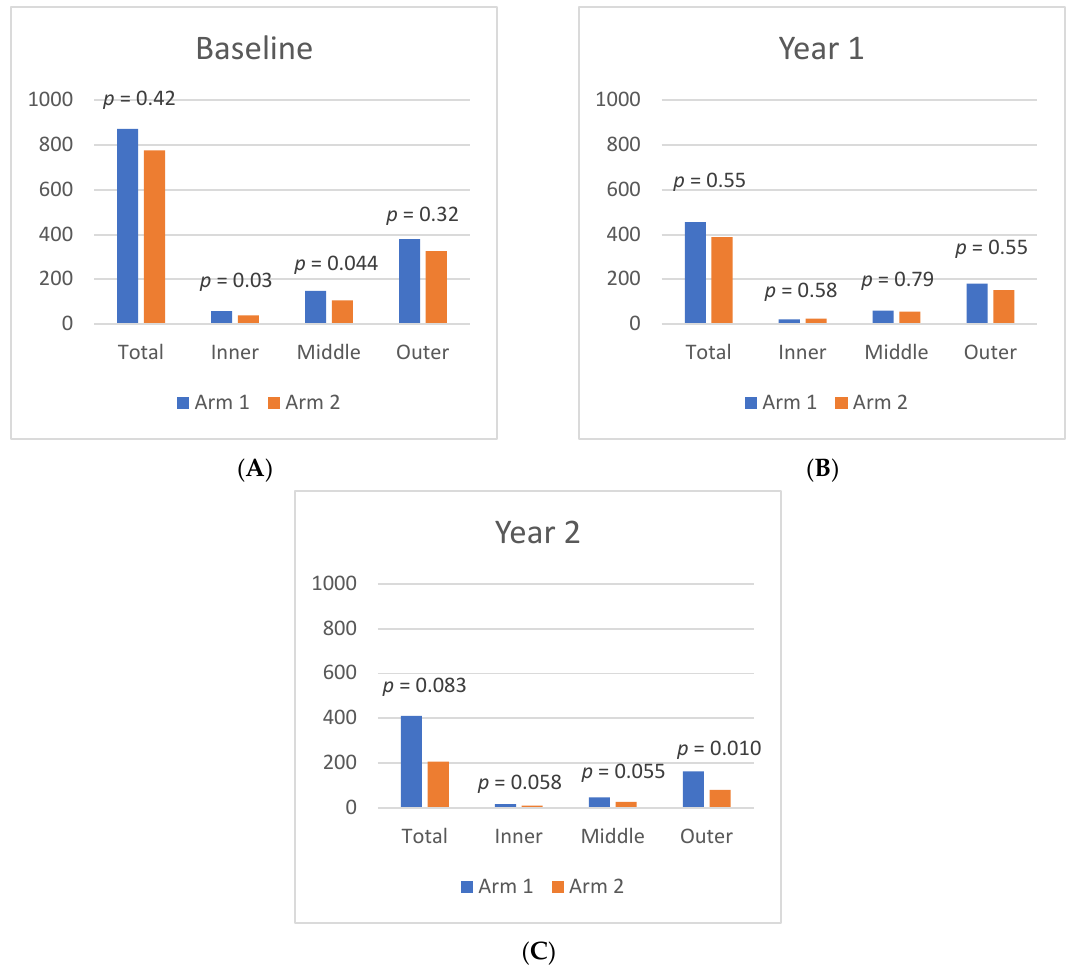
Figure 6. Differences in microaneurysm count per region between Arm 1 and Arm 2 at ( A ) Baseline, ( B ) Year 1, ( C ) and Year 2 .